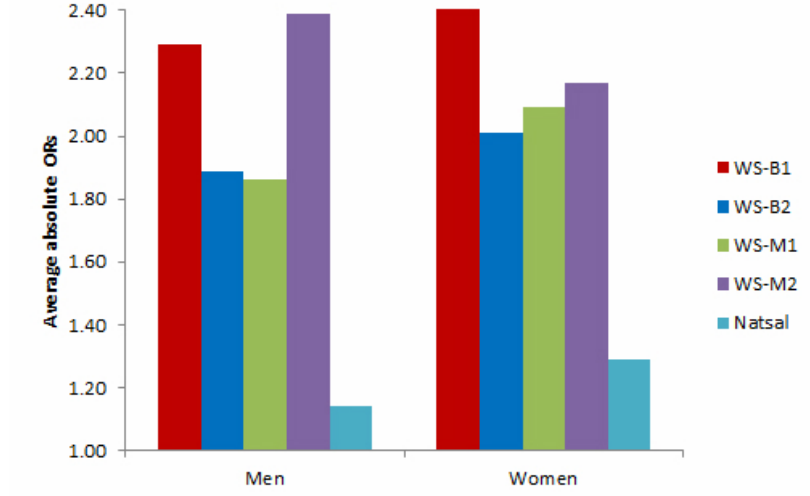
Comparing Key Estimates from the Web Surveys With Natsal-3